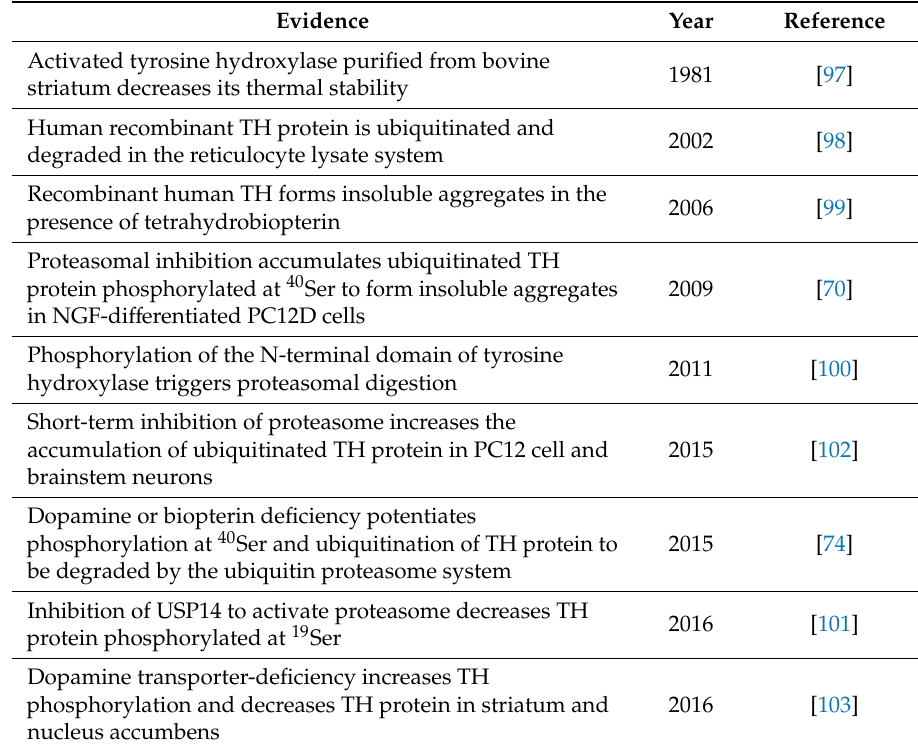
Table 1. Advances of the study for the ubiquitination and proteasomal degradation of phosphorylated tyrosine hydroxylase protein (original articles).